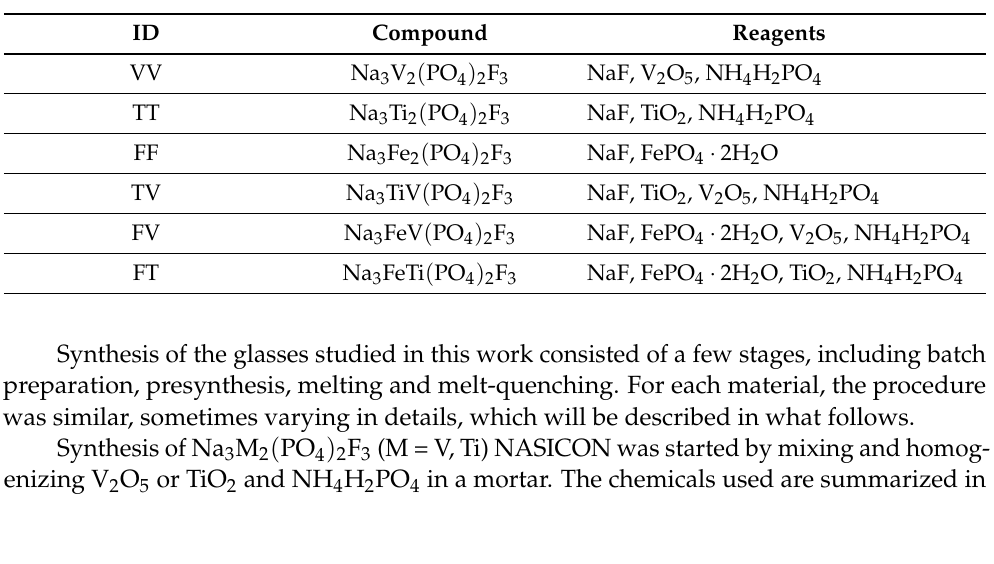
Table 1. Sample IDs and reagents used in their